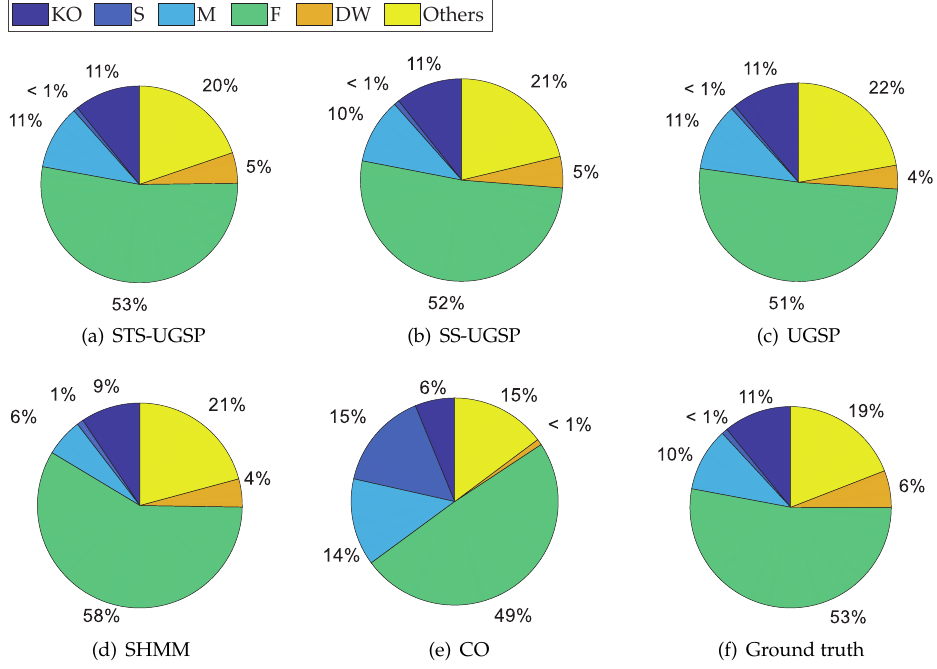
Figure 13. Pie charts of disaggregated energy shares for REDD House